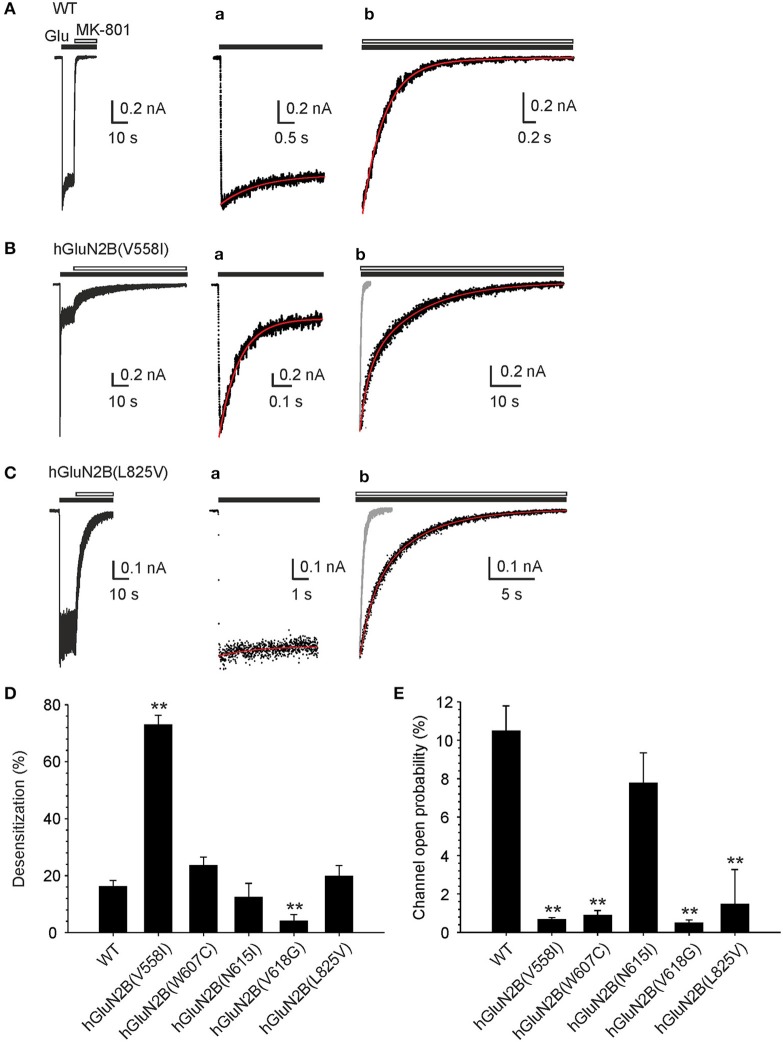
Mutations in the TMD alter receptor desensitization and Po. (A-C) Representative currents induced in WT, hGluN1/hGluN2B(V558I; and L825V) receptors by fast application of 1 mM glutamate (in the continuous presence of 30 μM glycine) and their inhibition by MK-801 (1 μM). (Aa-Ca) Show the response to glutamate at an expanded time scale. Desensitization of WT receptors was best described by rate constants kd = 0.17 s−1 and kr = 0.69 s−1; desensitization of hGluN1/hGluN2B(V558I) receptors by kd = 4.06 s−1 and kr = 1.12 s−1, and desensitization of hGluN1/hGluN2B(L825V) receptors by kd = 0.11 s−1 and kr = 0.83 s−1 (indicated by a superimposed red trace). (Ab-Cb) Show the onset of MK-801 inhibition on an expanded time scale. The time course of the onset of MK-801 (gray response in Bb and Cb) inhibition was best described by Po = 12.2% for WT receptors, Po = 0.61% for hGluN1/hGluN2B(V558I) receptors, and Po = 1.16% for hGluN1/hGluN2B(L825V) receptors (indicated by a superimposed red trace) (see Methods section for details of the analysis procedure). Graphs show the summary of mean desensitization (D) and Po
(E) ± SEM (n) for WT and mutated receptors. The differences in the mean values of desensitization and Po determined for the WT and mutated receptors was statistically significant; Kruskal-Wallis one-way ANOVA on Ranks, p < 0.001; subsequent Mann-Whitney Rank Sum Test or unpaired t-test was used to assess the significance compared to the WT, *p = 0.001–0.05, **p < 0.001.